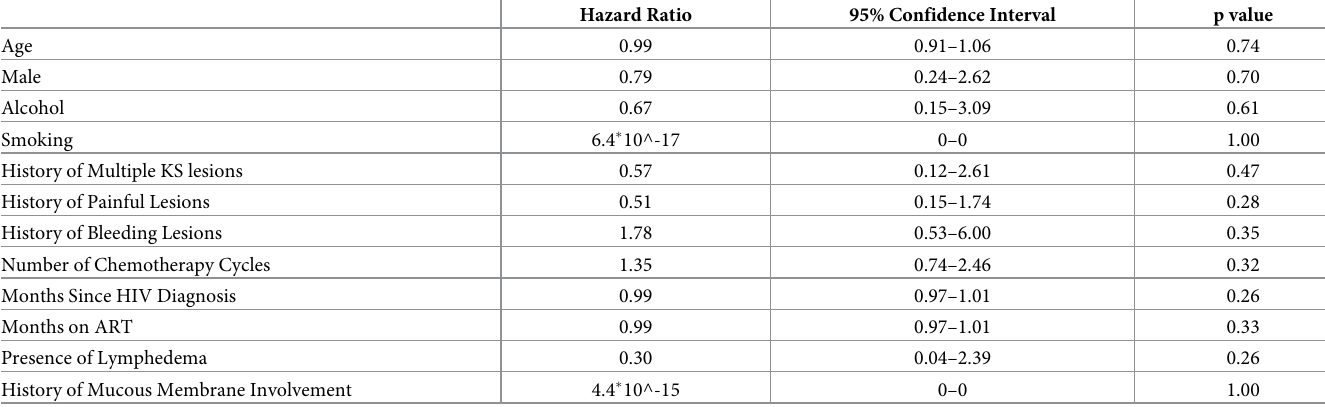
Table 2. Univariate cox regression on clinical and sociodemographic predictors of KS